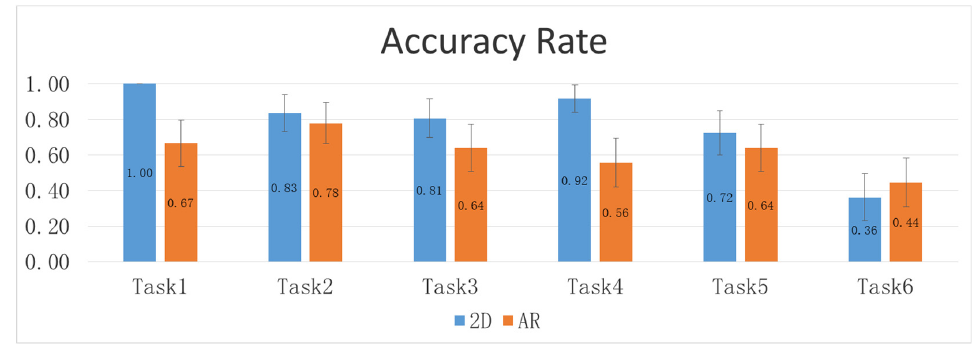
Figure 7. Accuracy rate for the six tasks with the 2D graph and the AR graph.